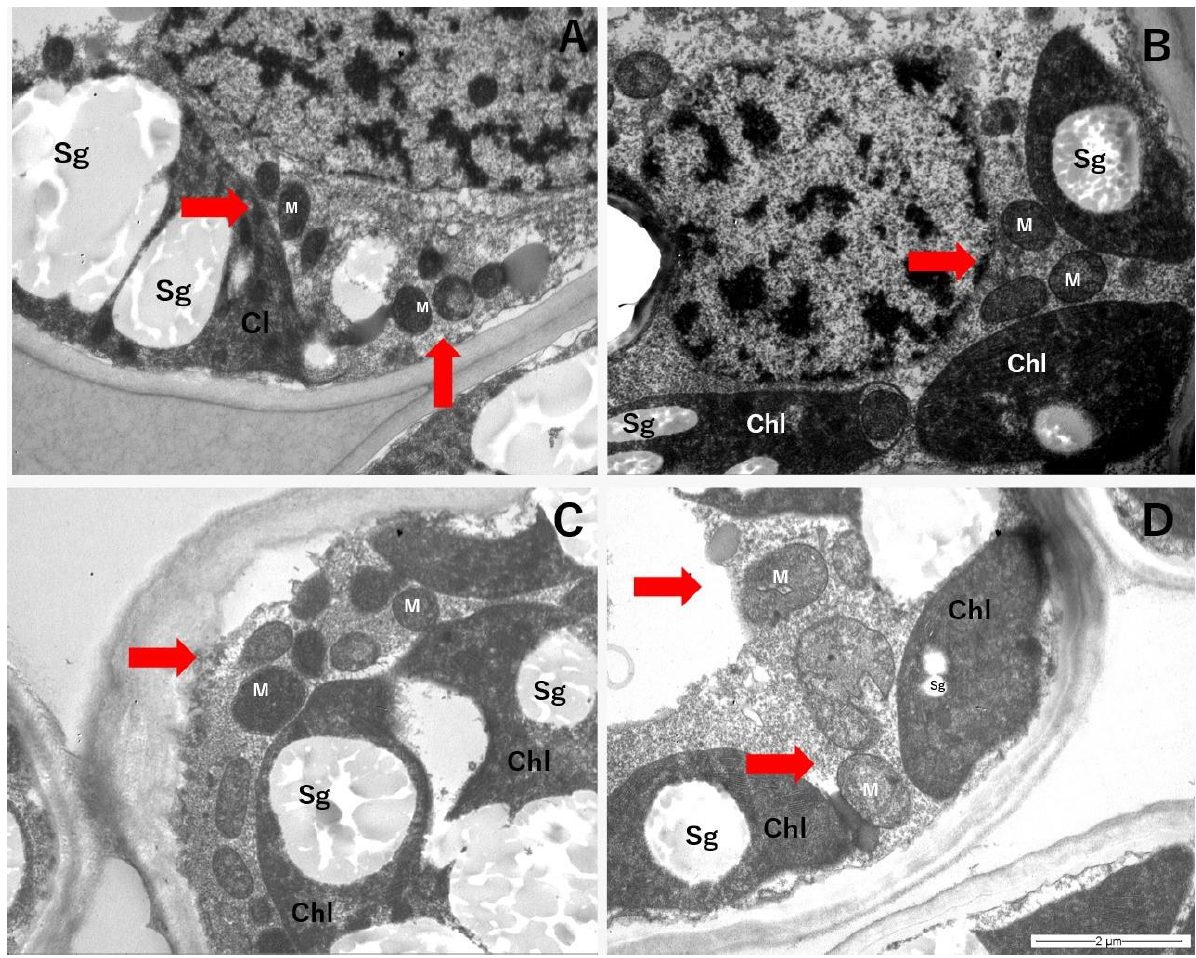
Figure 7. Mitochondria (M; red arrows), chloroplasts (Chl), and starch granules (Sg) from leaf mesophyll of D. antarctica exposed to AC (ambient CO 2 , control thermoperiod; A ), AW (ambient CO 2 , warming thermoperiod; B ), EC (elevated CO 2 , control thermoperiod; C ), and EW (elevated CO 2 , warming thermoperiod; D ). Microscope magnification = 11500X.